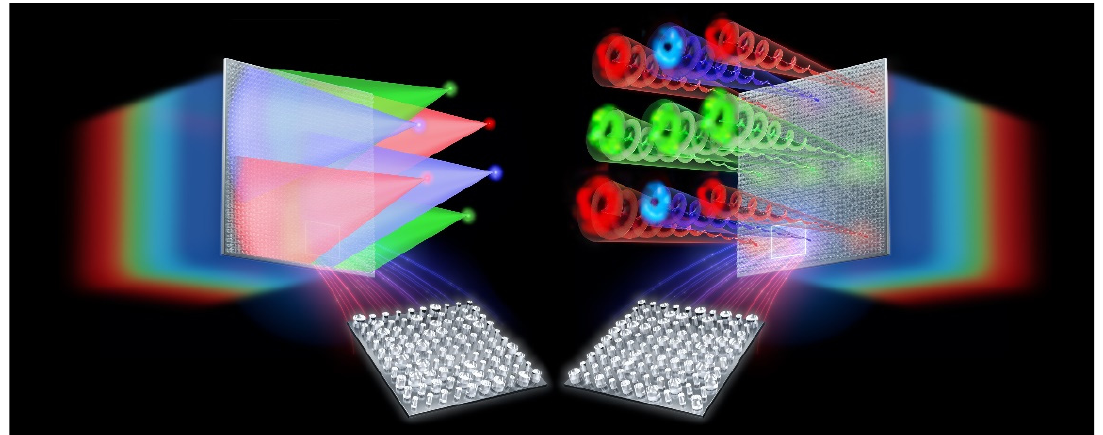
Figure 1. Schematic diagram of holographic metasurface for RGB three-wavelength multiplexing.